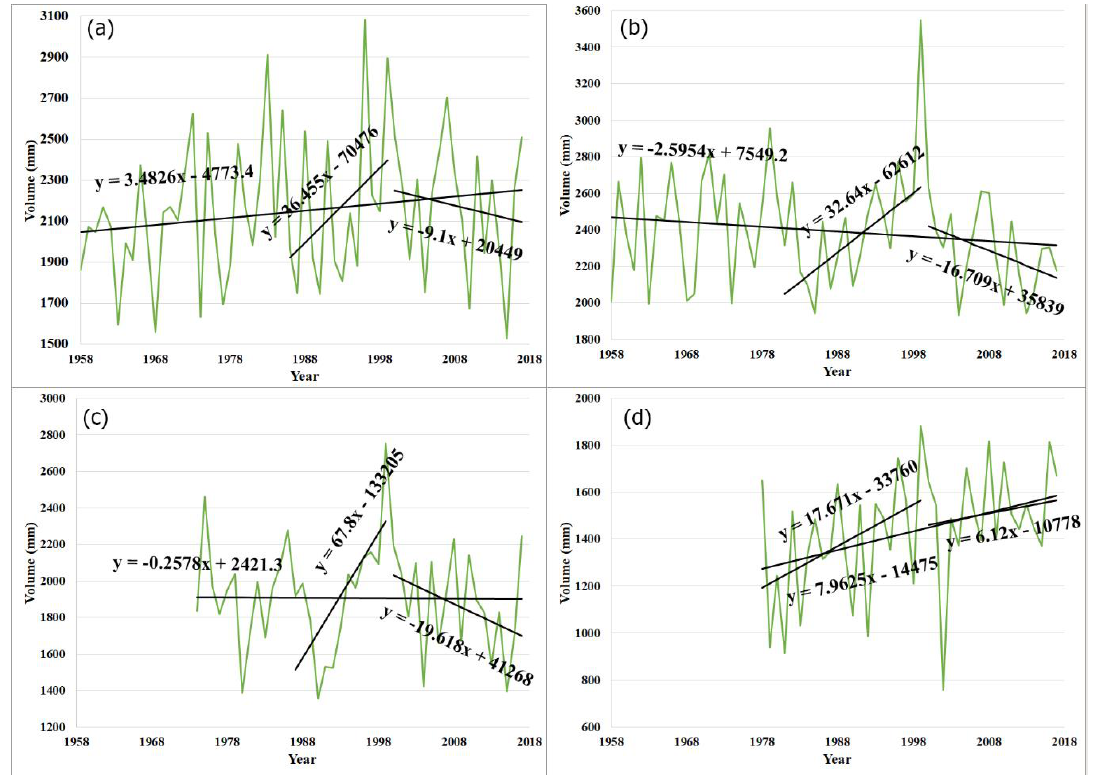
Figure 8. Trends in annual precipitation at monitoring stations at ( a ) Rach Gia, ( b ) Ca Mau, ( c ) Soc Trang, and ( d ) My Tho.